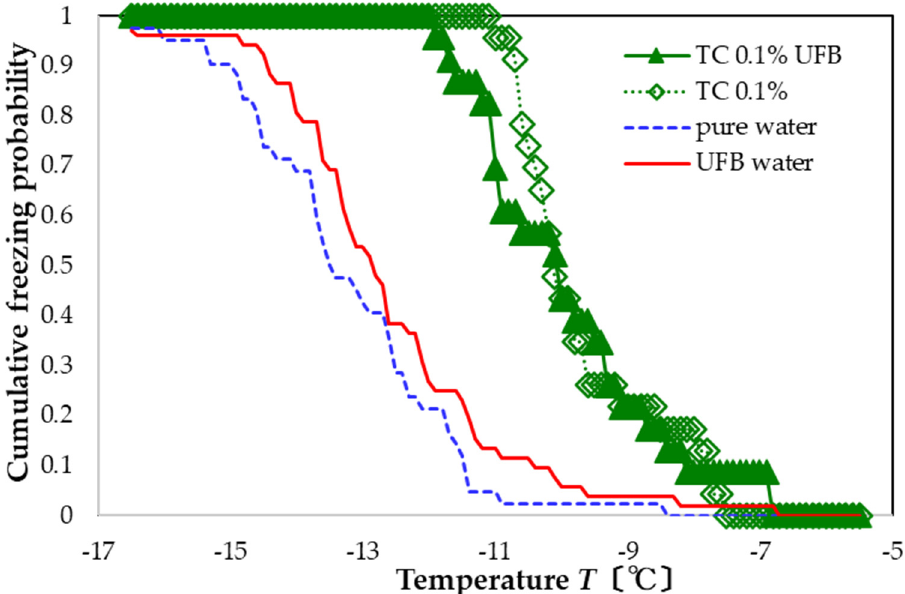
Figure 7. Freezing curve of aqueous solution with 0.1 wt% TC dissolved in water with UFBs (solid green). Other curves shown for comparison.